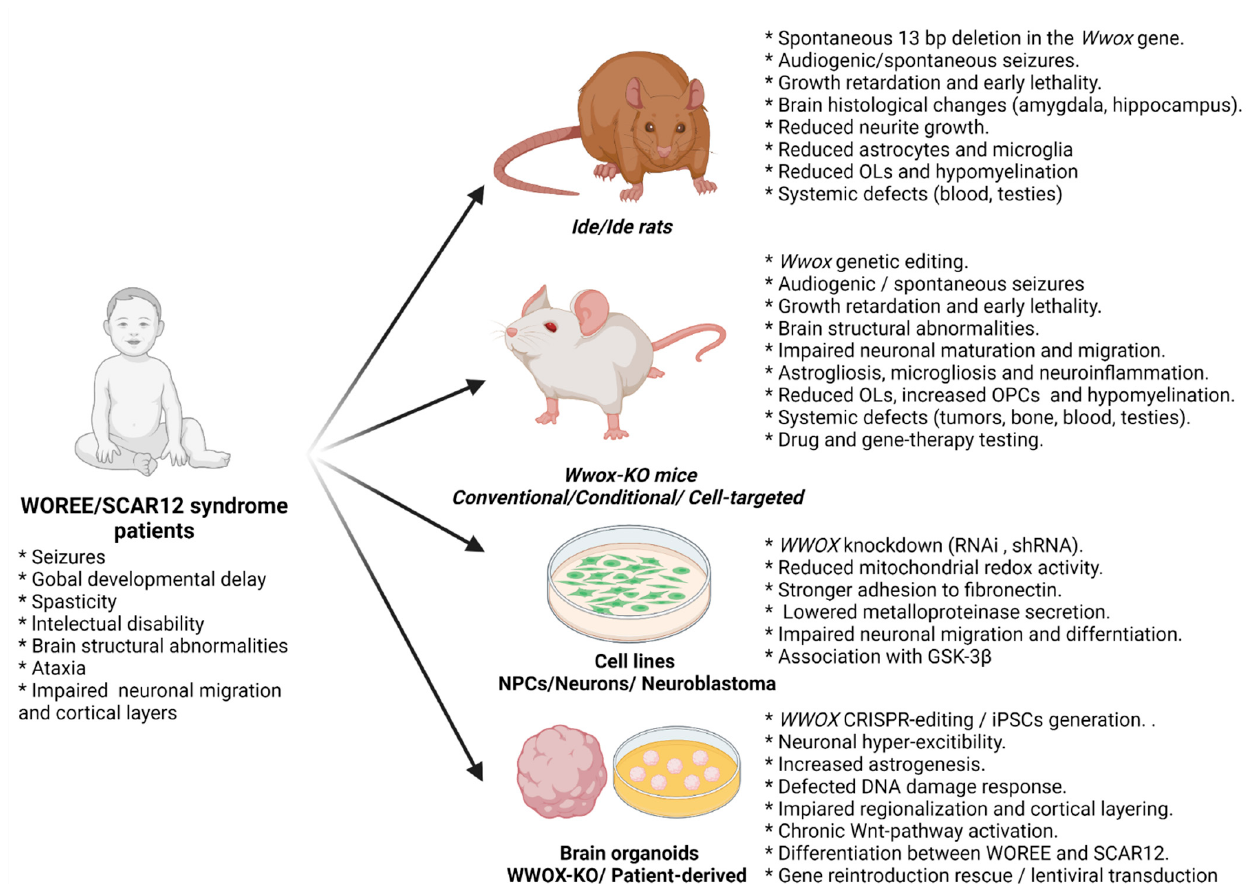
Figure 2. Summary of the available systems for modeling WWOX loss of function and the observed